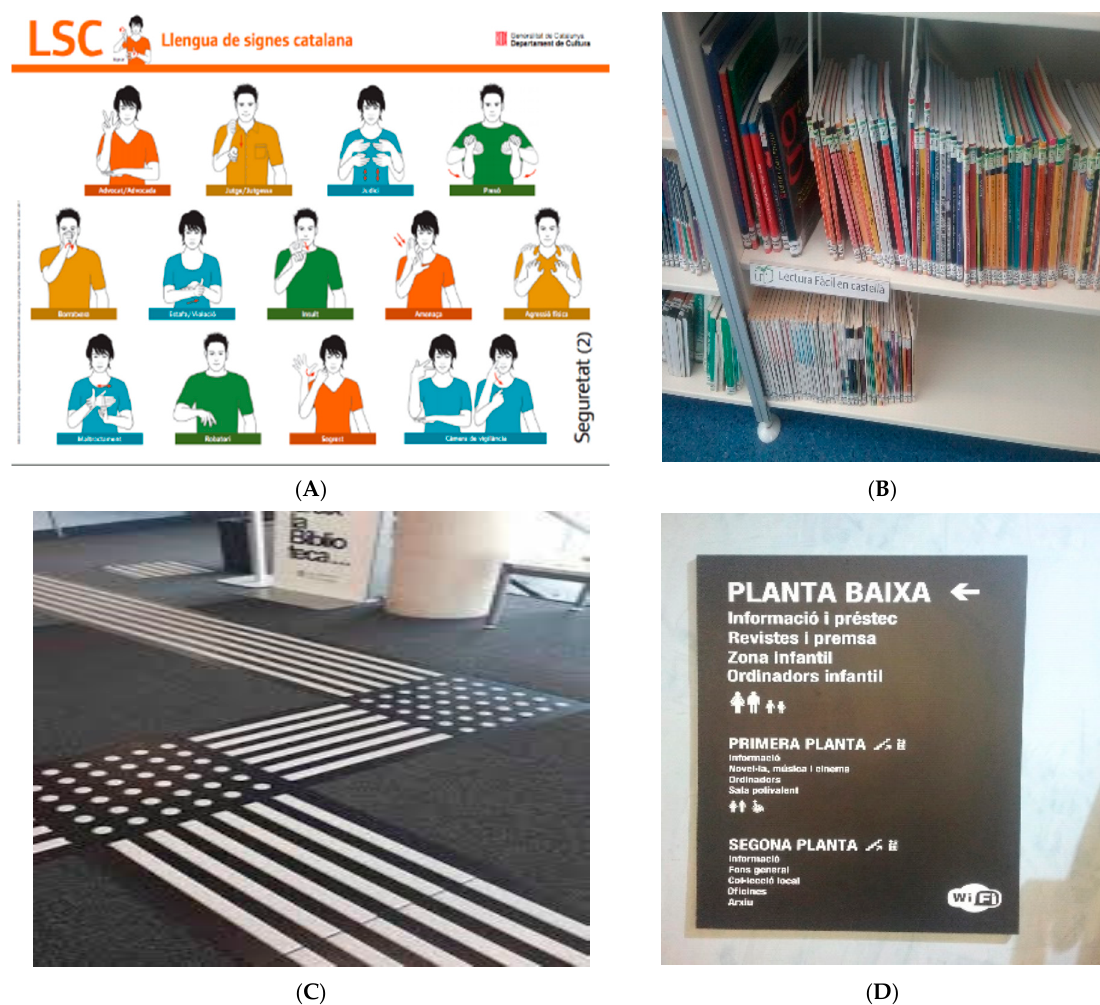
Figure 3. ( A ) Sign language displayer for library staff implemented in all the libraries. ( B ) Acquisition of a huge portfolio of books in plain language for students with intellectual disabilities. ( C ) Podotactile bands implemented in libraries for blind students. ( D ) Signage posting adapted to Universal Design standards to the communication needs of users (plain language, contrasting colours,